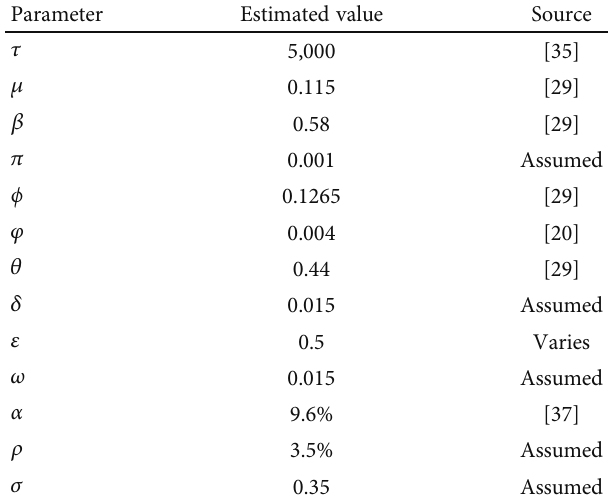
Table 3: Description of parameter estimation in the model.